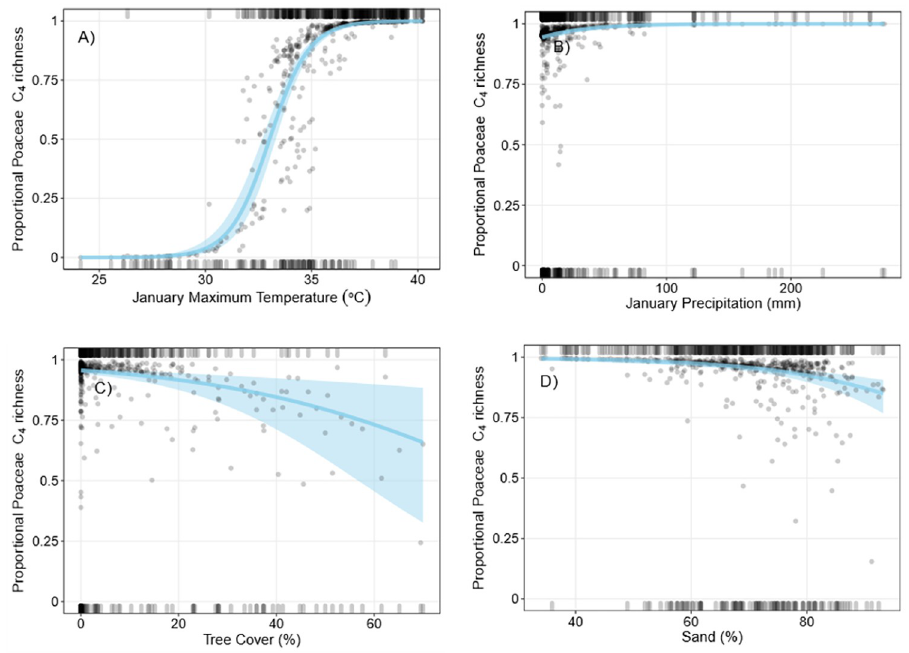
Fig 2. Binomial logistic regressions of proportional C 4 Poaceae richness. Grey points are partial residuals, blue lines and shaded bands are predicted outcomes of the regression and 95% confidence intervals respectively, and rugs were drawn to indicate observations with positive residuals (top of the plot) or negative residuals (bottom of the plot). For each plot (A-D), independent variables not depicted on the x-axis are held constant at their median value.